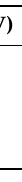
Table 2. Vertical ionization potentials (IP) and electron affinities (EA) calculated with the GW method for the L0, L2, L3, and L4